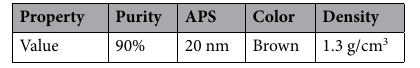
Table 3. The physical properties of DSNP .